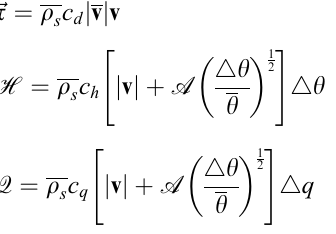
but for G100ST60 ( dotted ) and G100 ( dashed ) with surface fluxes of heat and moisture and deep convection added to the parametriza- tions. Values plotted in units of 10 5 J m (cid:255)